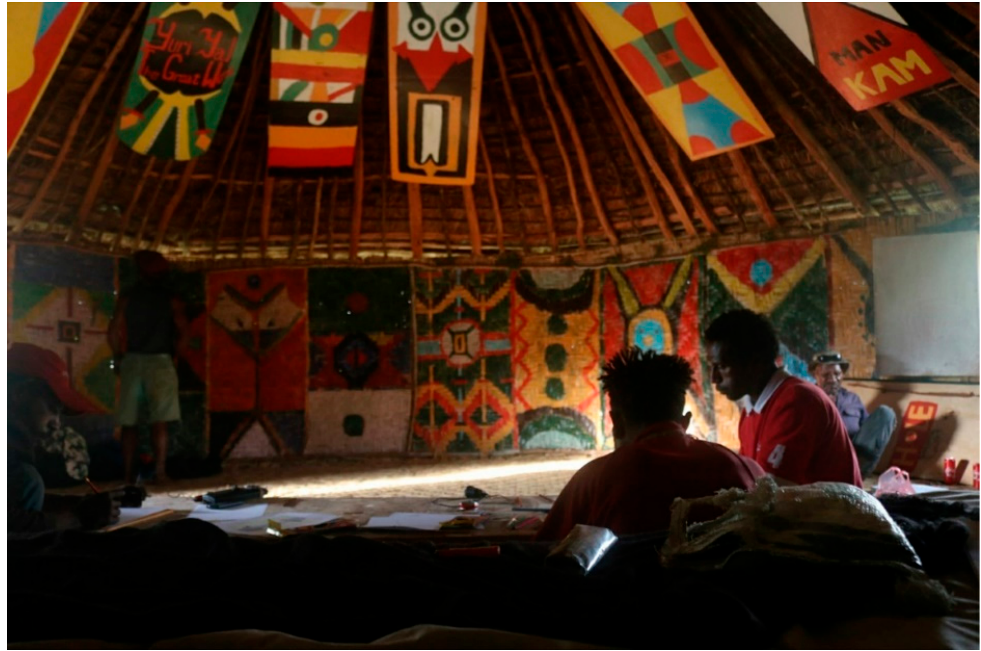
Figure 18. Members of the art collective Haus Yuriyal work on paintings based on the art form of ancestral shields in their round house in the Wahgi Valley of Papua New Guinea. Photograph by Eric Bridgeman.